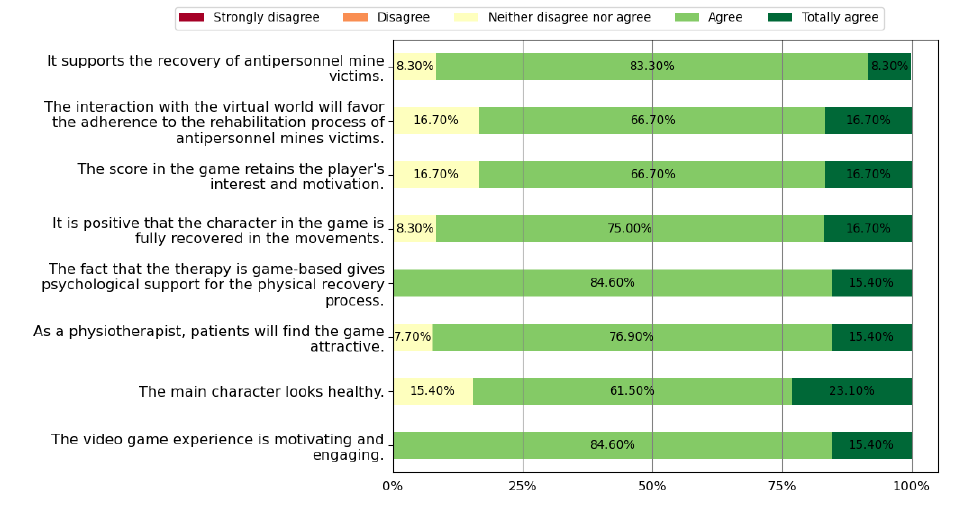
Figure 8. Perceptions related to